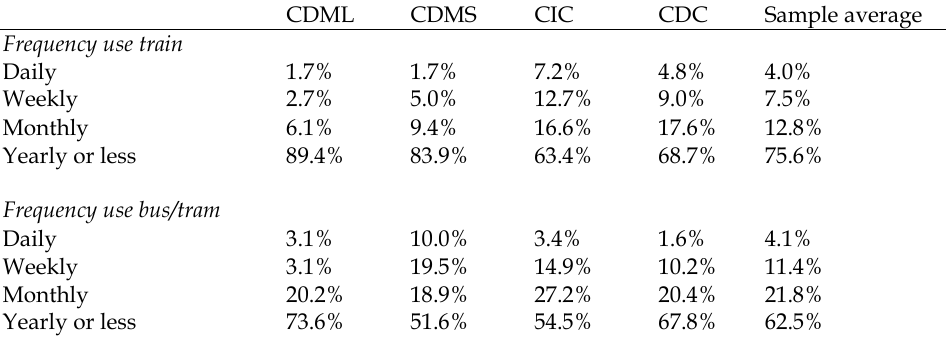
Table 4: Use of public transport (%) (Assympt. significance Pearson Chi-square p<0.01).